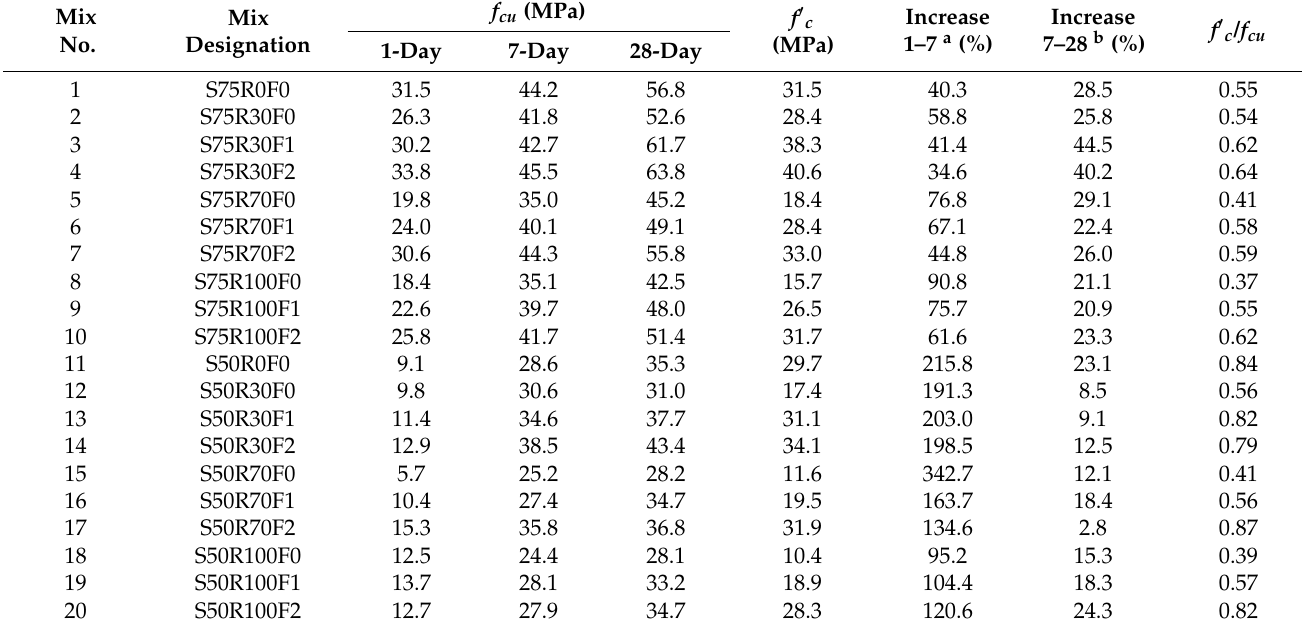
Table 5. Compressive strength of alkali-activated slag-fly ash concrete